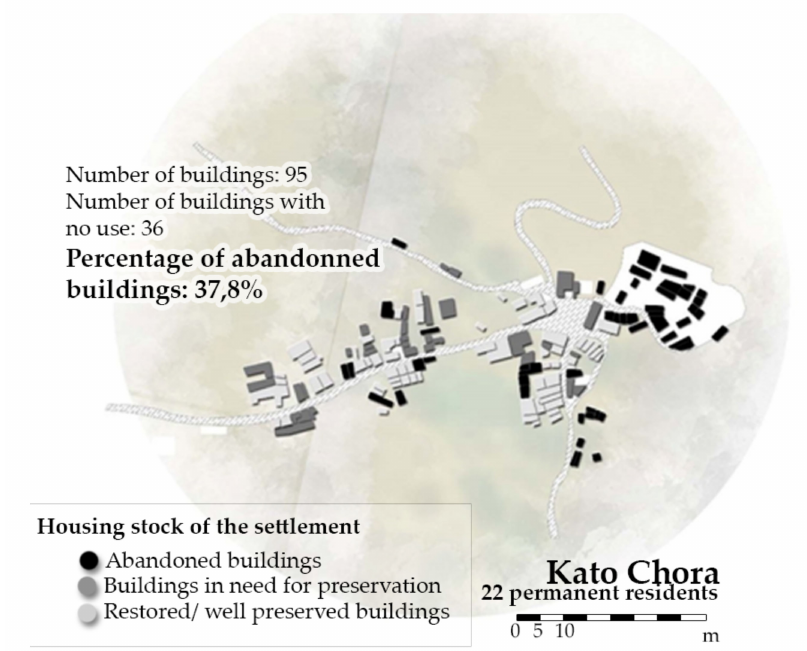
Figure 24. The housing stock of Kato Chora.